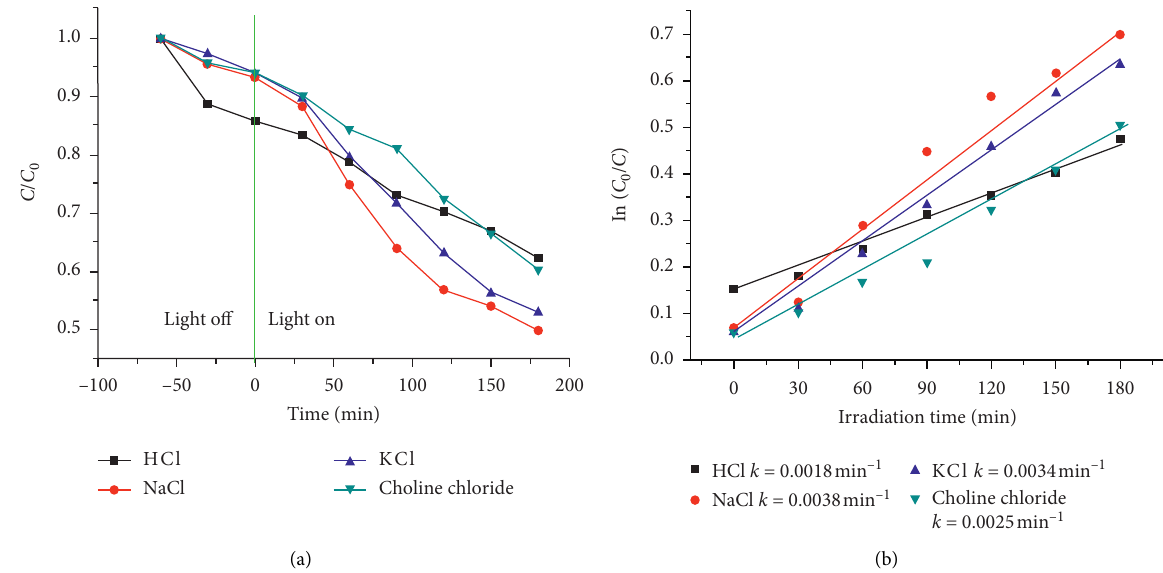
Figure 2: Effects of chlorine source on the carbamazepine degradation kinetics.